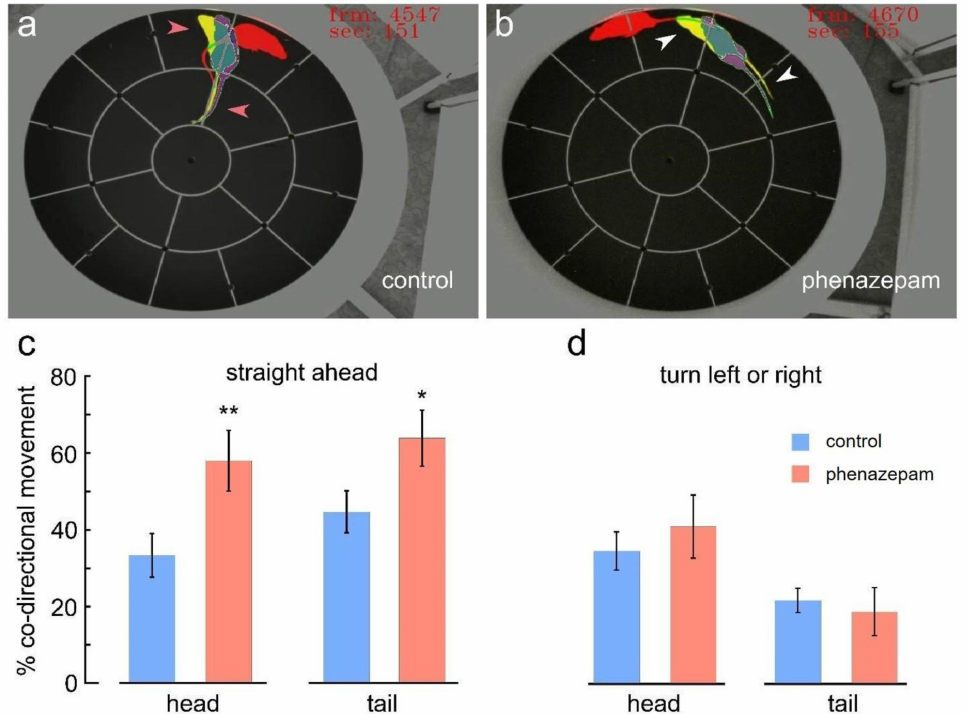
Figure 4. Differential percent of head and/or tail co-direction regarding the future rat locomotion. For the time- and color-coding details, see the main text and the Figure 2 caption. ( a ) Example of head and tail non-co-directional position in a control animal (red arrowheads). ( b ) Example of both head and tail co-directional positions in a phenazepam-treated animal (white arrowheads). ( c ) Averaged percent of head (left bars) and tail (right bars) co-directional positions in straight ahead locomotion for each recorded animal in the control (blue bars) and phenazepam (red bars) groups ( t -test: *— p < 0.05; **— p < 0.01). ( d ) Averaged percent of head (left bars) and tail (right bars) co-directional positions in left/right turn locomotion for each recorded animal in the control (blue bars) and phenazepam (red bars) groups ( t -test not